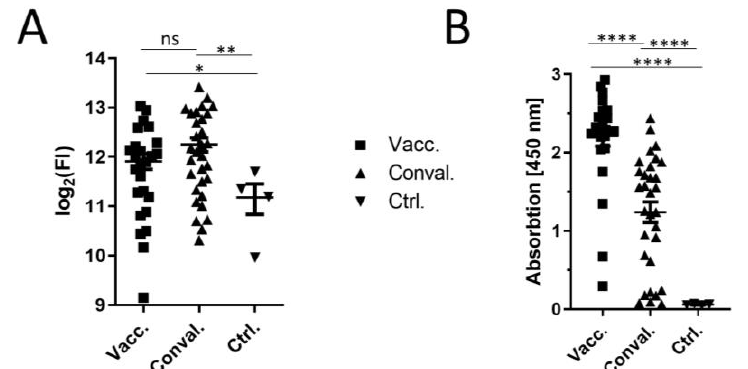
Figure 2. Validation of the peptide array results. ( A ) FI means of the 50 highest peptides from the different sera groups. ( B ) Anti-RBD ELISA of the different sera groups. Vacc.: vaccine-elicited sera; Conval.: convalescent; Ctrl.: Neg. sera. (non-vaccinated and non-infected) * p -value ≤ 0.05; ** p -value ≤ 0.01; **** p -value ≤ 0.0001.